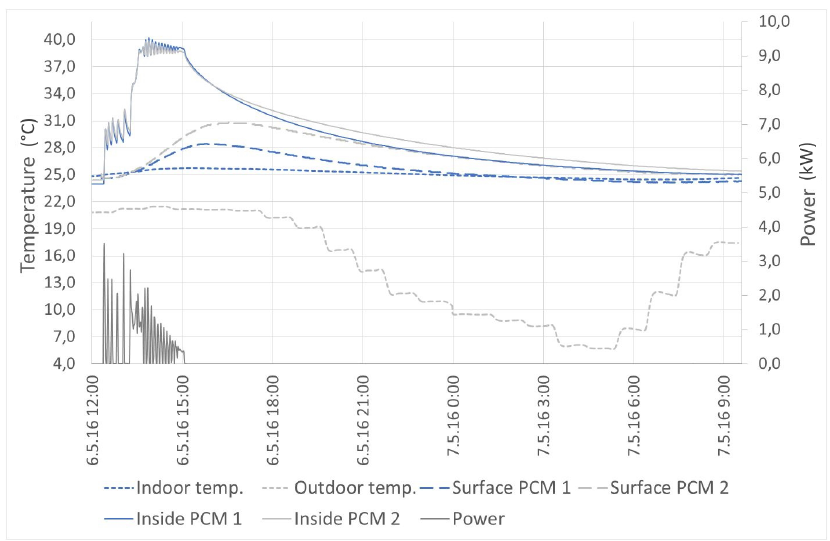
Figure 12. Active mode: